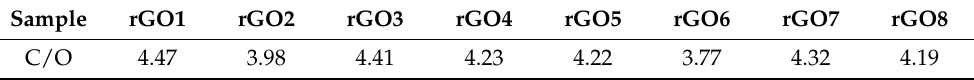
Table 5. The atomic ratios of carbon to oxygen for all reduced graphene oxides. Sample